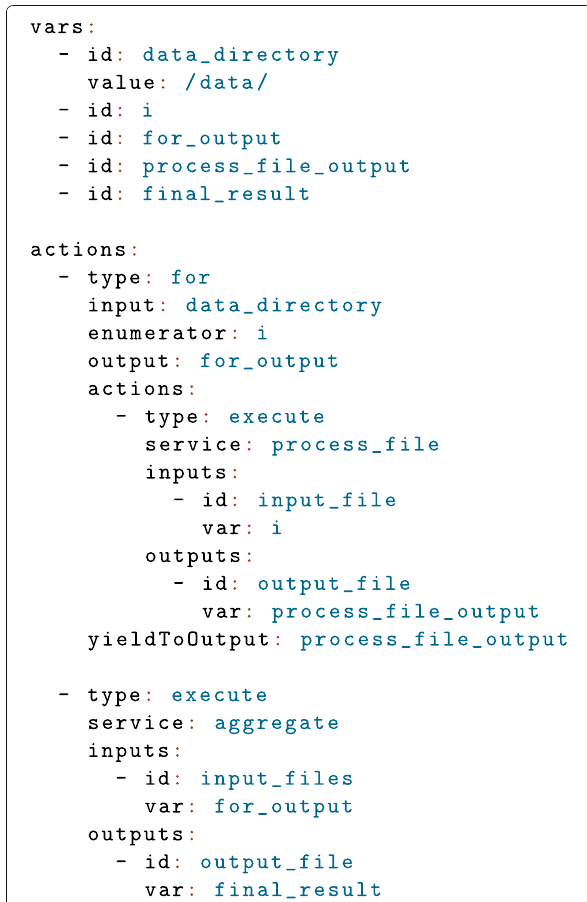
Fig. 3 Simple example workflow model in YAML notation